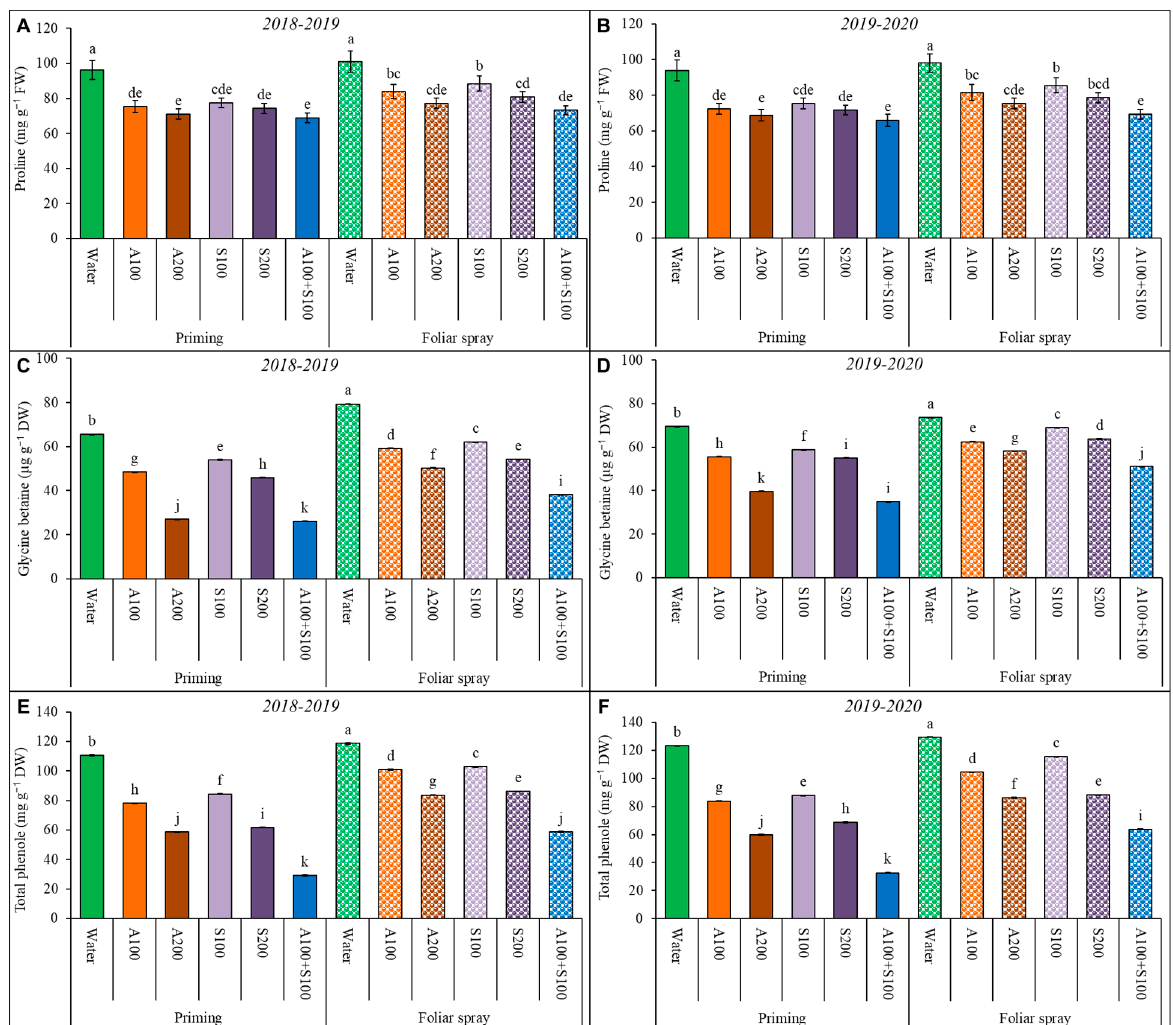
Figure 6. Effect of foliar spray and priming with antioxidant AA and SA on proline ( A , B ); glycine betaine ( C , D ); and total phenols ( E , F ) contents of wheat leaves in the two winter seasons 2018/2019 and 2019/2020. Data are mean ± standard error ( n = 4). Letters represent significant differences between treatments at p < 0.05 level according to the LSD test.